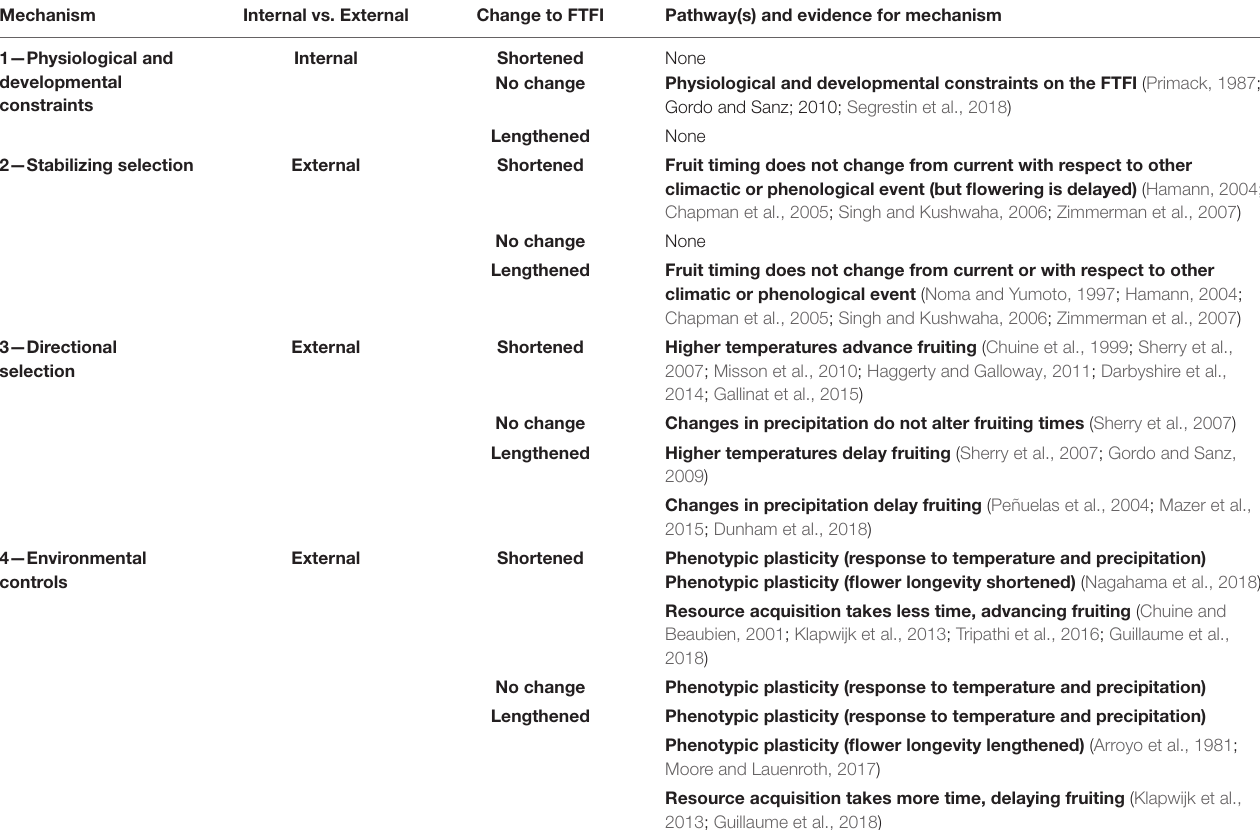
TABLE 2 | Proposed mechanisms for how the flowering to fruiting interval (FTFI), the time between the flowering and ripe fruit phenophases, will change or remain stable with climate change. Mechanism Internal vs. External Change to FTFI Pathway(s) and evidence for